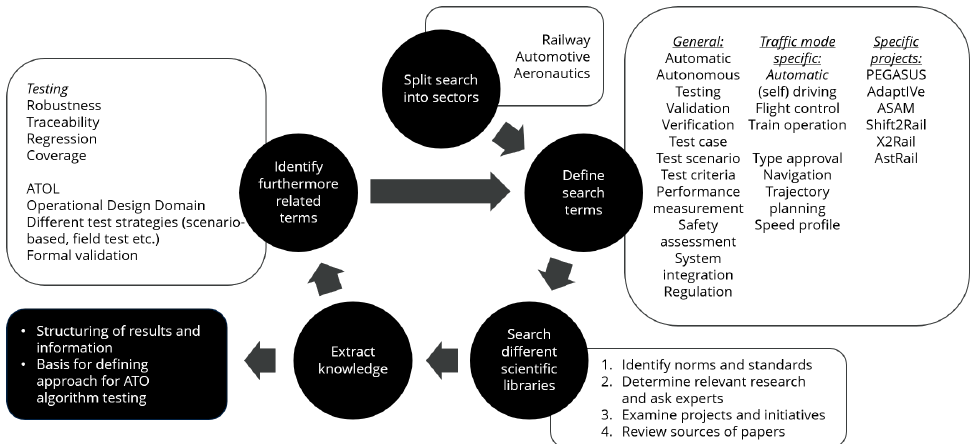
Figure 1. Visualization of the literature review process including examples for search terms and identified related